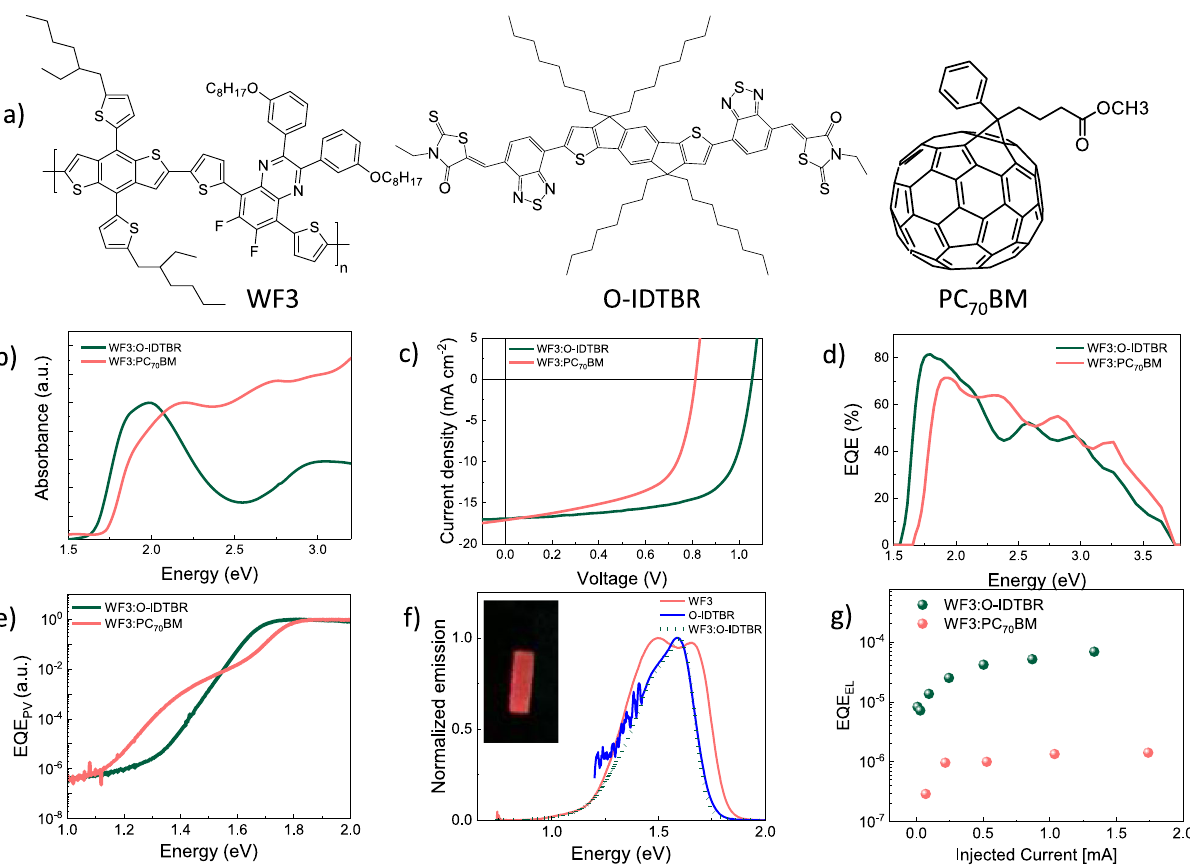
Fig. 1 Steady-state characterisation of organic solar cells. a Chemical structures of the donor and acceptor materials used in this work. b Absorption spectra of WF3:O-IDTBR and WF3:PC 70 BM blends. c Current density – voltage characteristics under 1 sun illumination for WF3:O-IDTBR and WF3:PC 70 BM devices. d External quantum ef fi ciency measurements of the same devices as shown in ( c ). e Sensitive EQE measurements (EQE PV ) for the same devices as shown in ( c ). f Electroluminescence spectra of the pristine materials and the WF3:O-IDTBR blend. The inset depicts a photograph of the WF3:O-IDTBR electroluminescence (the original photograph can be found in the SI). g EQE EL of WF3:O-IDTBR and WF3:PC 70 BM devices as a function of the driving